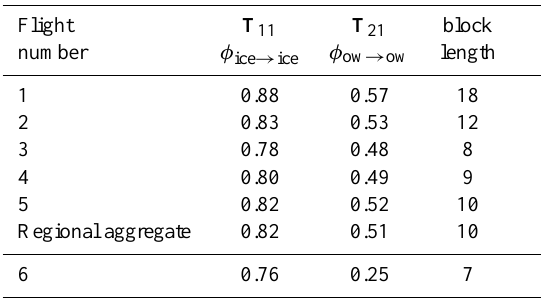
Figure 8. Same as in Fig. 7 but for flight 6 shown in Fig. 3. Solid blue line is for the image-based track average albedo of 0.32, and dashed lines show the 25 and 75% (0.23,0.42) of the respective α i probability density shown in (b) ; (c) bootstrap swath-based aggre- gate albedo α s probability density, and solid line shows the fitted normal pdf N ( 0 . 32 , 0 . 02 2 ) . Table 3. Auxiliary data for the processed flight tracks used in the calculation of the flight-track albedo. T 11 and T 21 denote elements of the transition matrix of the fitted first-order Markov model and the respective estimated image block